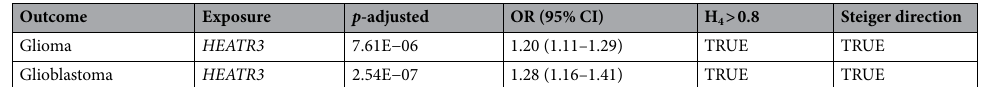
Table 5. The MR results for the analysis of differential gene expression in blood tissue with glioma and glioblastoma risk. P-adjusted, p-value adjusted for FDR. MR effect estimates are reported as odds ratios